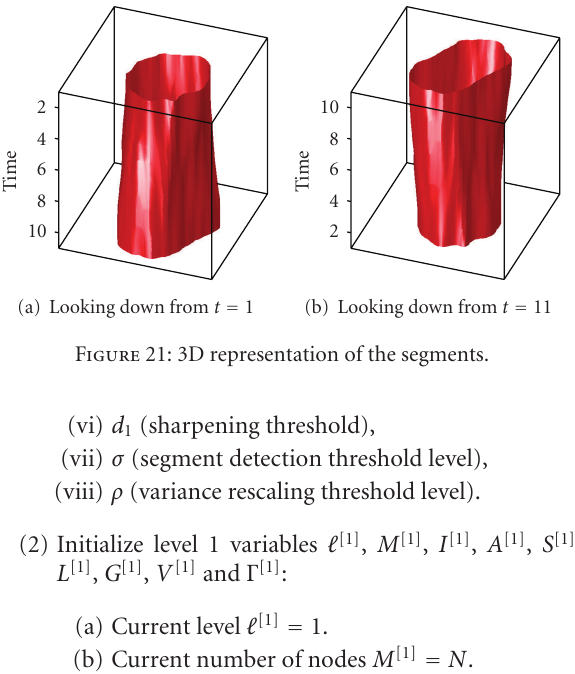
Figure 21: 3D representation of the